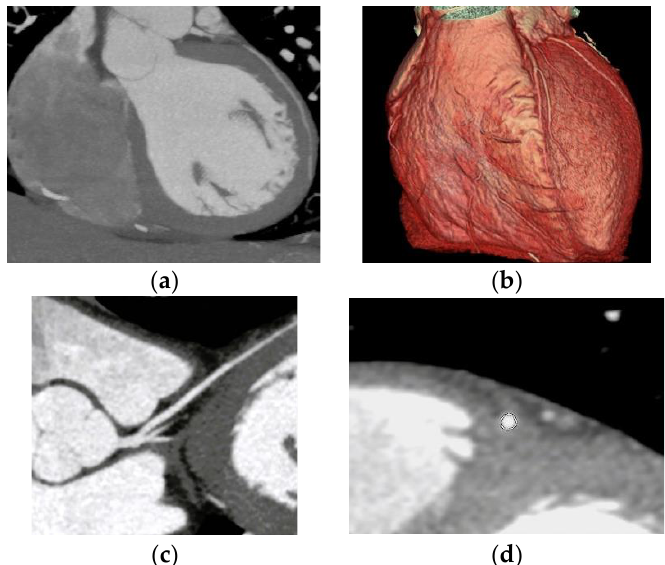
Figure 6. Intramuscular bridging of the left anterior descending artery. ( a ) CCTA oblique sagittal maximum intensity projection image of the LAD route shows intramuscular bridging of the left anterior descending artery in the second segment for a 30 mm distance and 3 mm depth; ( b ) CTAA volume rendered 3D images show the LAD in the atrioventricular groove entering an intramural route; ( c ) CCTA curved planar reformatted image of the LCA entering an intramural route; ( d ) CCTA vessel cross-section image of the LCA with intramural course.